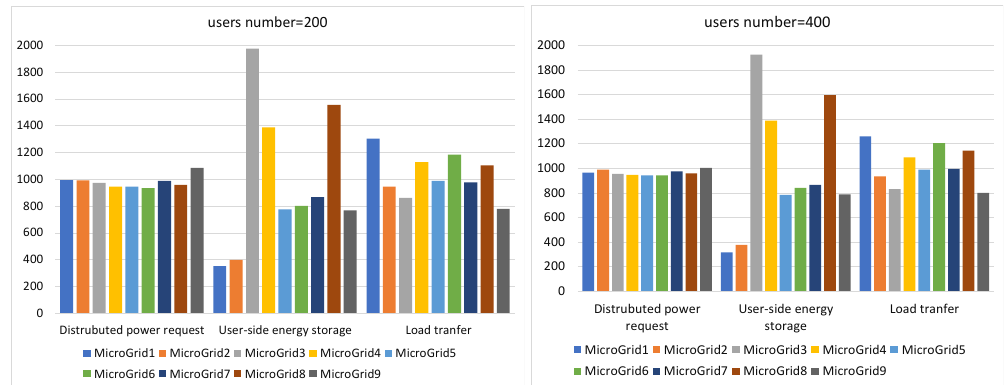
Figure 7. Energy Supplied by Each Micro-grid using different methods.